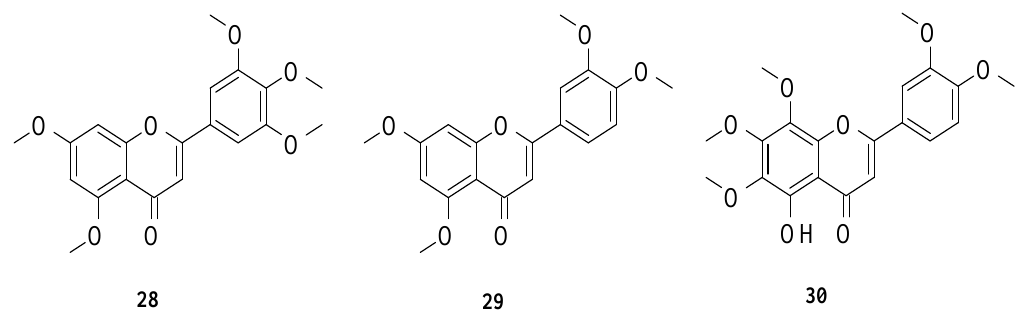
Figure 6. Chemical structures of flavonoids isolated from M. paniculata [32]. Bello et al. examined three flavonoids isolated from Vitex grandifolia which is traditionally used by the Yoruba community in southwest Nigeria to treat various disorders [33]. The flavonoids were identified as isoorientin ( 26 ), orientin ( 31 ), and isovitexin ( 32 ) (Figure 7). The anti-inflammatory activity of the compounds was evaluated by using two different assays, viz., nuclear factor kappa B (NF- κ B) inhibition and inducible nitric oxide synthase (iNOS) inhibition. The results showed that all compounds exerted good inhibition against NF- κ B, with IC 50 values of 8.9, 12, and 18 µ g/mL for 26 , 31 , and 32 , respectively. On the other hand, only 32 exhibited moderate activity for iNOS inhibition with an IC 50 of 21 µ g/mL. Meanwhile, the other two compounds, viz., 26 and 31, showed poor iNOS inhibition (IC 50 = 48 and 54 µ g/mL, respectively). The authors discussed the structure–activity relationship of these three flavonoids. Firstly, the C2–C3 double bond might influence the anti-inflammatory activity of flavonoids. Next, the -OH groups at C3′ and C4′ , as shown in 26 and 31 , can increase the anti-inflammatory activity. In addition, the presence of sugar moiety in the A-ring compared to the B- and C-rings will lead to better anti-inflammatory activity.